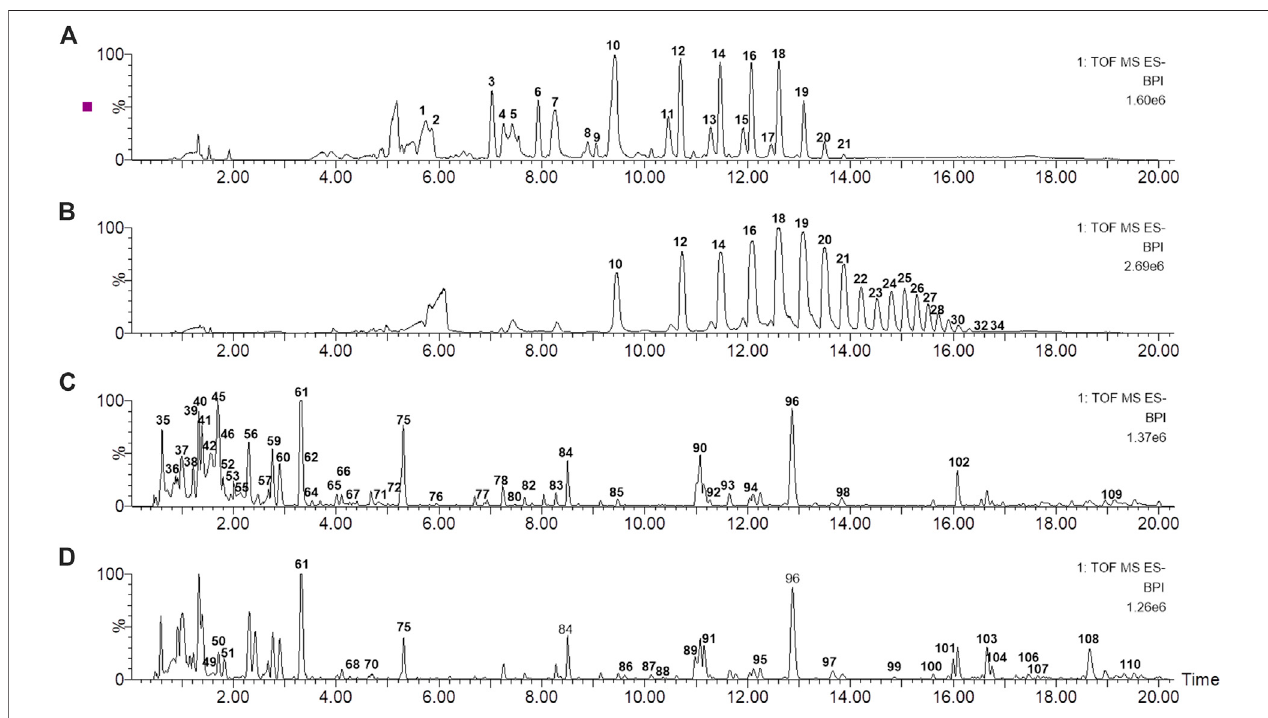
FIGURE 1 | Base peak ion chromatograms of processed Morindae of fi cinalis Radix (PMOR) (A,C) and Morindae of fi cinalis Radix (MOR) (B,D) analyzed by ultrahigh-performance liquid chromatography coupled with quadrupole time-of- fl ight mass spectrometry (UHPLC-Q-TOF MS) in the negative ion mode. (A,B) were analyzed with an Acquity BEH amide column; (C,D) were analyzed with an Acquity BEH